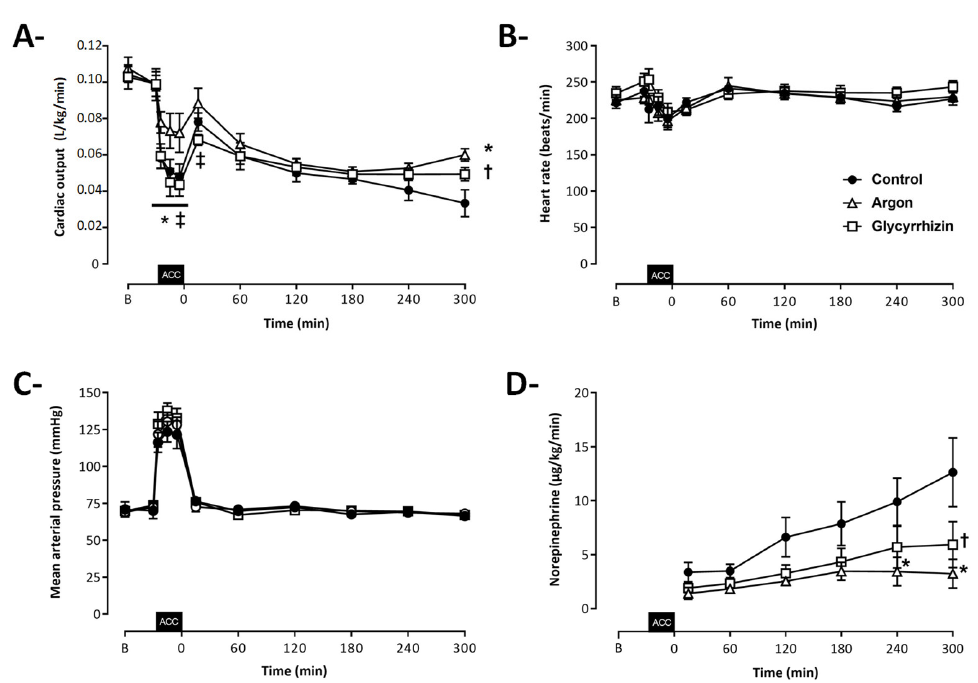
Figure 2. Cardiac output ( A ), heart rate ( B ), mean arterial pressure ( C ) and norepinephrine regimen of administration ( D ) throughout protocol. ACC: Aortic cross clamping; * p < 0.05 between Control and Argon; † p < 0.05 between Control and Glycyrrhizin; ‡ p < 0.05 between Argon and Glycyrrhizin; Control ( n = 7), Argon ( n = 7), Glycyrrhizin ( n = 7).